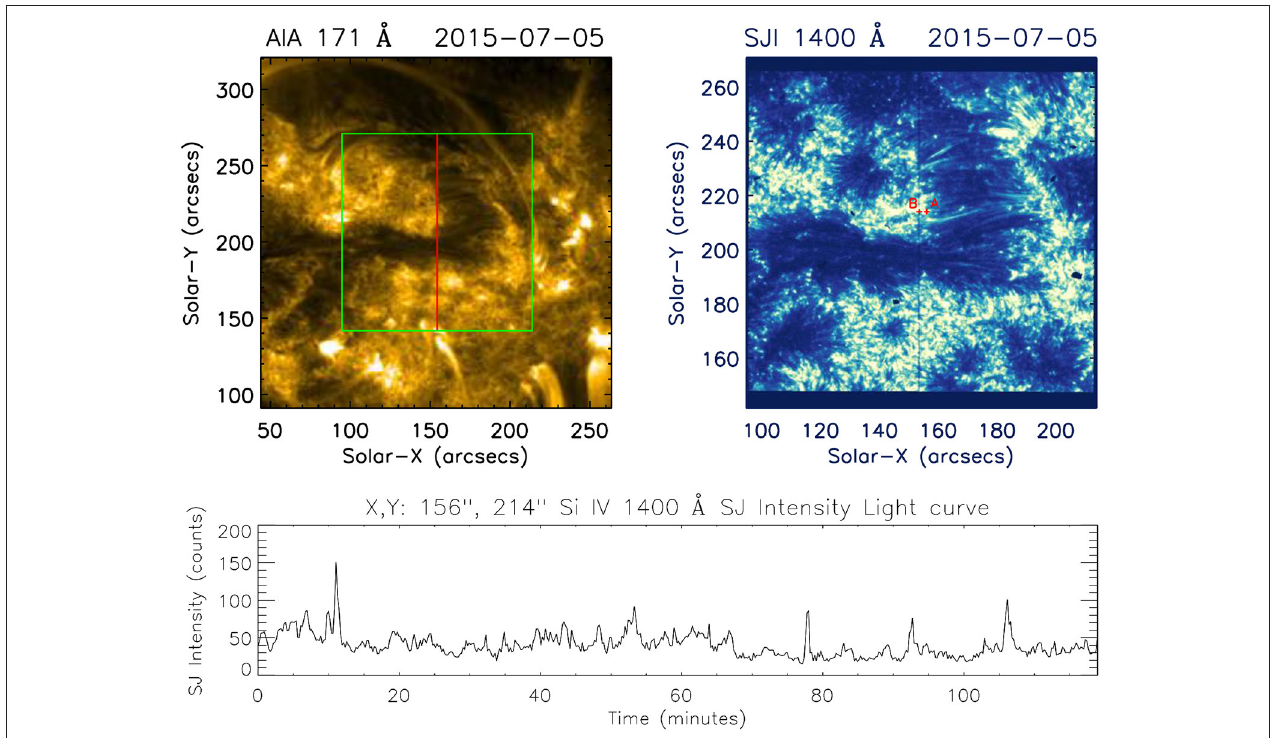
FIGURE 1 | AIA 171Å image marking the observed region by IRIS and SJI at a particular instance as observed by IRIS in the SiIV1400Å passband. The bottom panel shows the SJ intensity light curve at location A marked in SJI FOV for the complete duration of the observation.